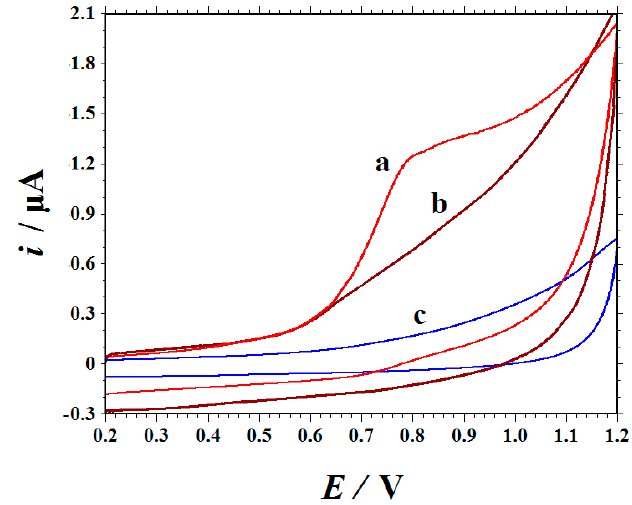
Figure 1. The cyclic voltammograms in the 0.1 M phosphate buffer (pH 7.0) recorded on the molecularly imprinted polymers (MIP)/acetylene black paste electrode (ABPE) before extraction (curve a) and after extraction (curve b), non-imprinted electrode (NIP)/ABPE (curve c). Scan rate: 0.1 V s − 1 .